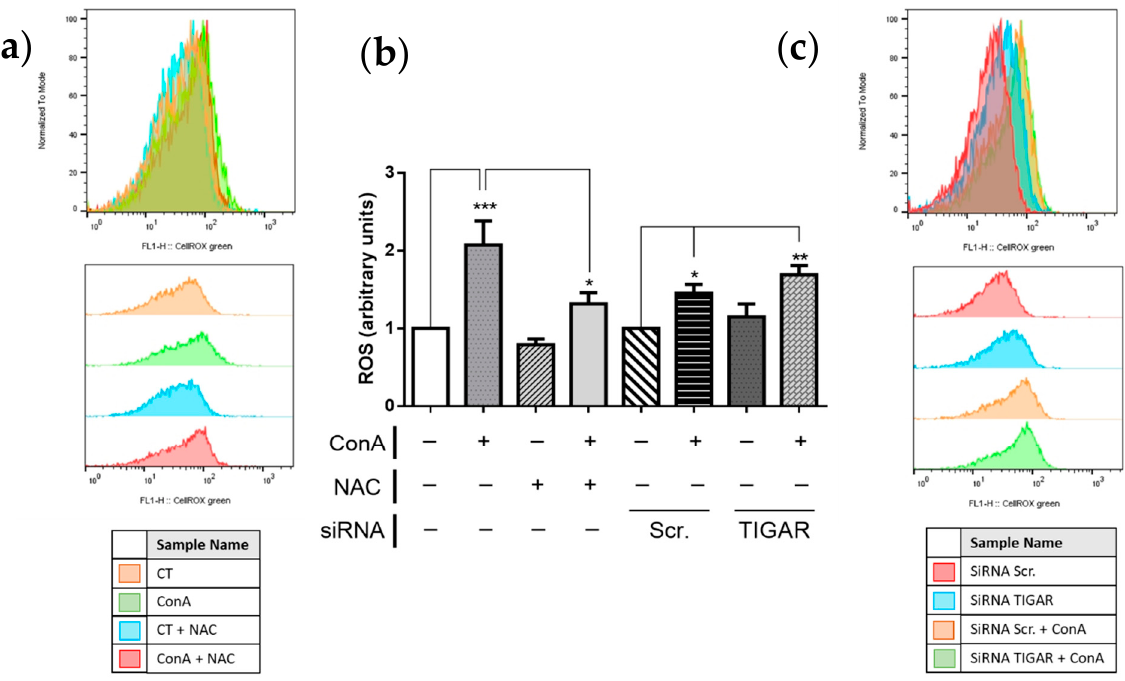
Figure 4. Analysis of ROS levels in silenced and antioxidant treatment lymphocytes after antioxidant treatment or TIGAR knockdown. ( a , c ) Raw data of CellROX Green fluorescence peaks of a representative experiment. ( b ) Cytometry analysis of ROS levels in T lymphocytes in different conditions; 20 mM NAC, 10 µg/mL ConA, and 75 nM siRNA TIGAR. The results are presented as a mean of all the measures. Differences were calculated with two-way ANOVA and Tukey’s multiple comparisons test with a normal-based 95% CI and ± SEM. Significant p values are indicated; * p < 0.05; ** p < 0.01 *** p < 0.001; n = 3.